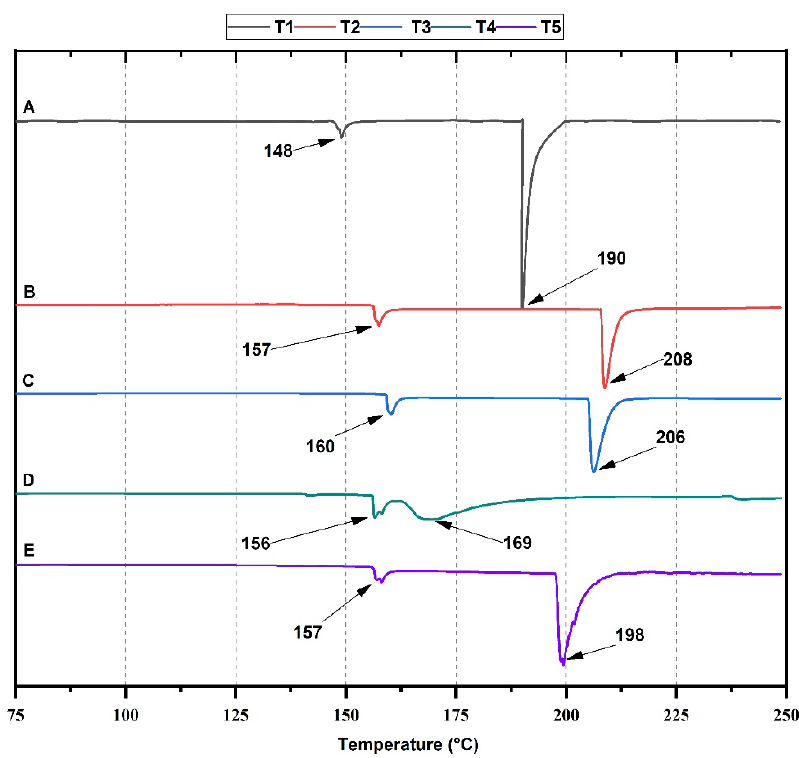
Figure 3. DSC thermogram of films: T1, ( A ) gelatin/cassava starch 0:100; T2, ( B ) gelatin/cassava starch 25/75; T3, ( C ) gelatin/cassava starch 50/50; T4, ( D ) gelatin/cassava starch 75:25; T5, ( E ) gela- tin/cassava starch 100/0.